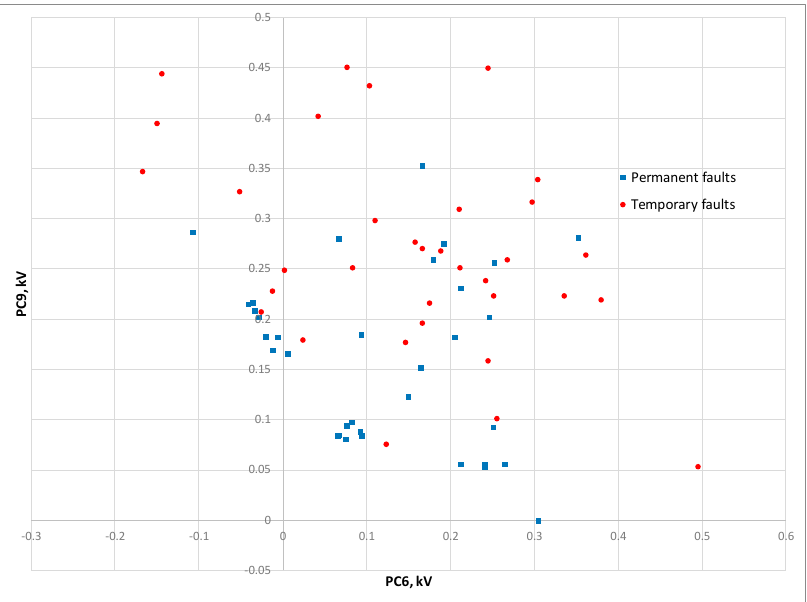
Figure 8. Permanent and temporary faults in the second and fifth subspace of PCs.